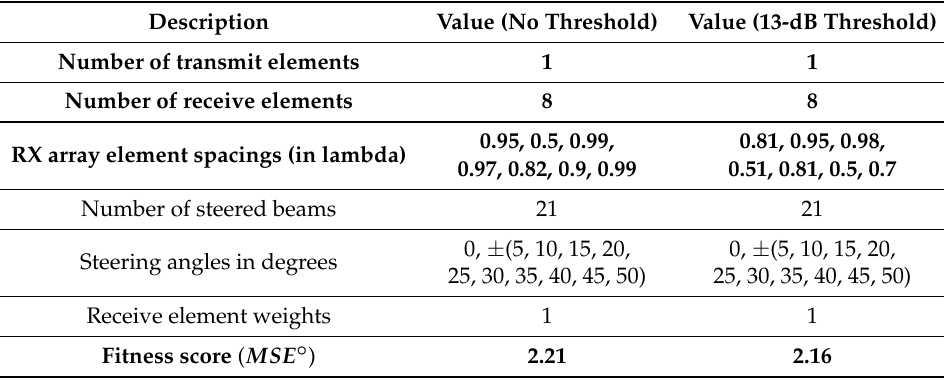
Table 8. Experiment 2